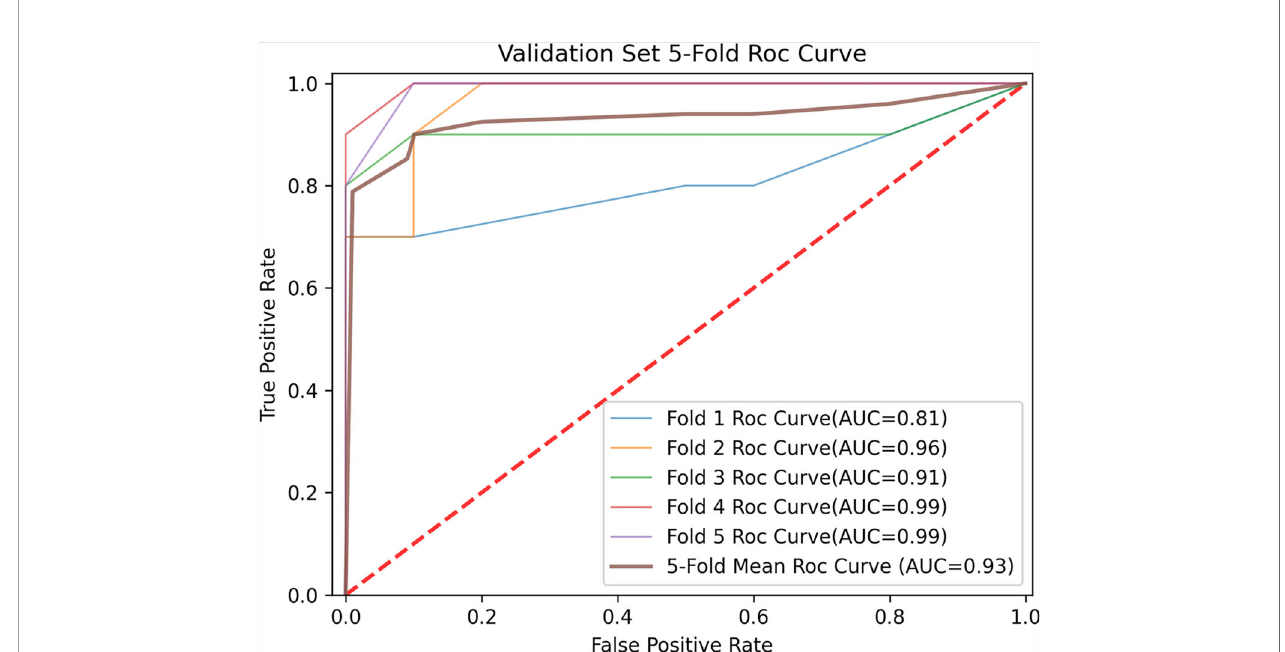
FIGURE 4 | Fivefold and mean receiver operating characteristic (ROC) curve for prediction in the validation